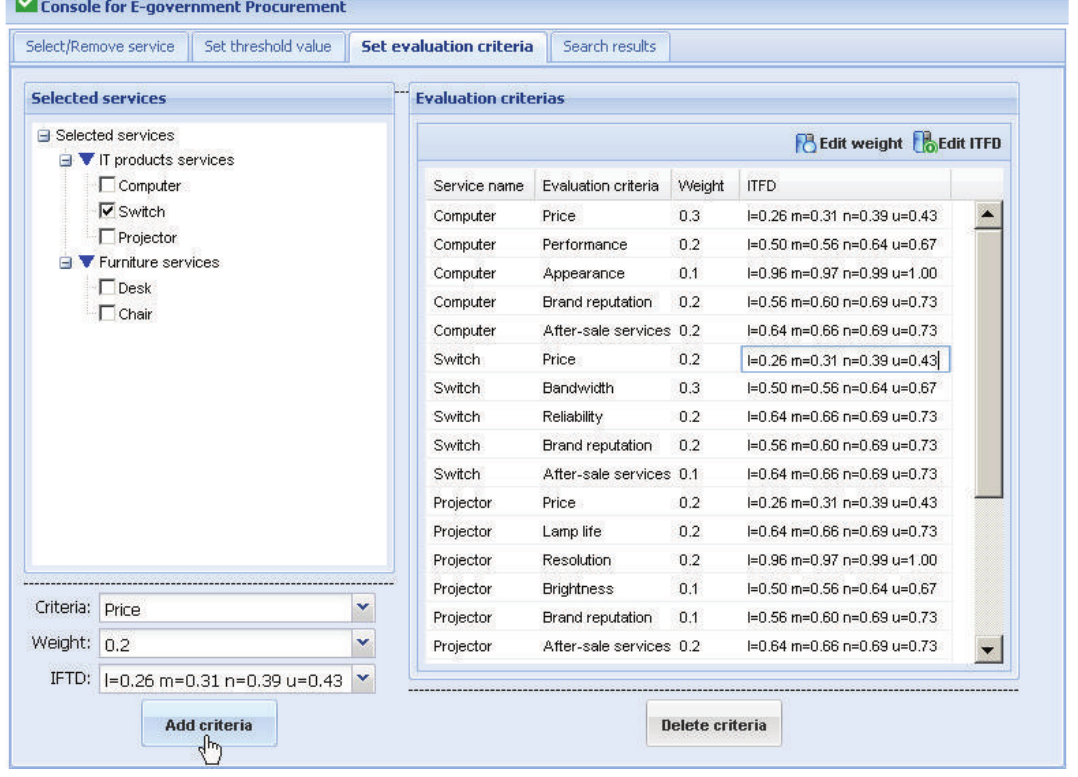
Figure 5: Graphical user interface for setting evaluation criteria of service